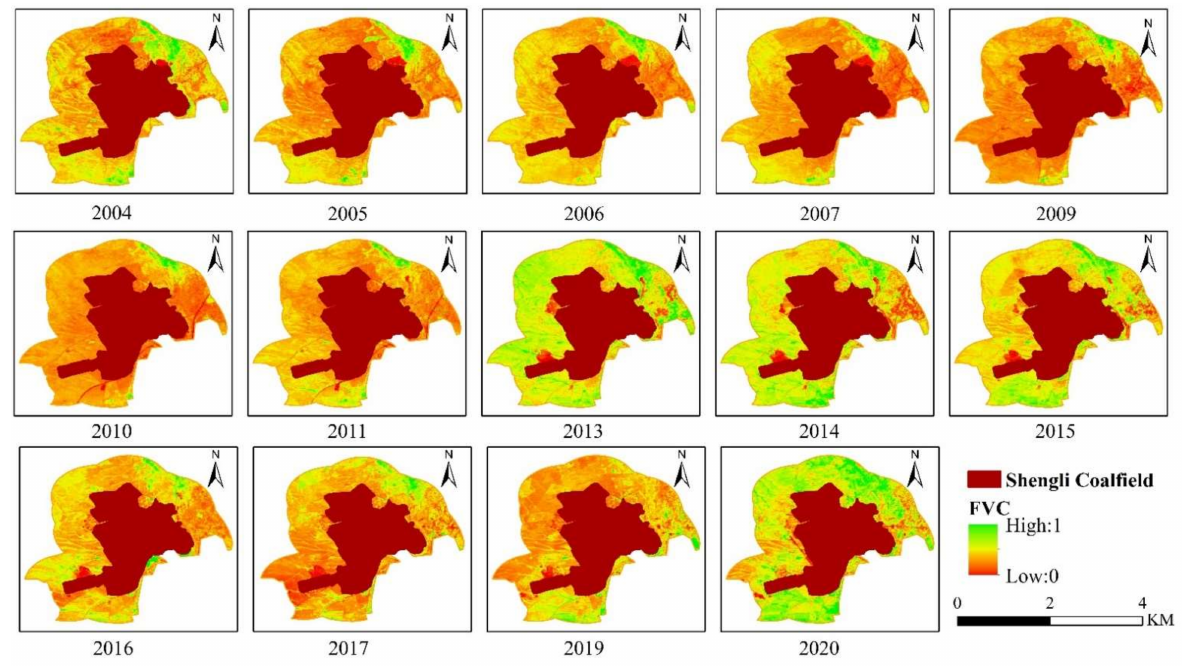
Figure 9. The spatial distribution of FVC from 2004 to 2020 (except 2008, 2012, and 2018). We then computed the average factor contributions of the ten analysis units for a given year at varying distances from the boundary of the mining area, and the results are displayed in Figure 10. The contribution of each driving factor shows similar characteris- tics. Over the years, the contributions of the different driving factors constantly changed. Precipitation and temperature have a downward trend, while mining and urban expansion have an increasing trajectory. The topography contributions remained unchanged.